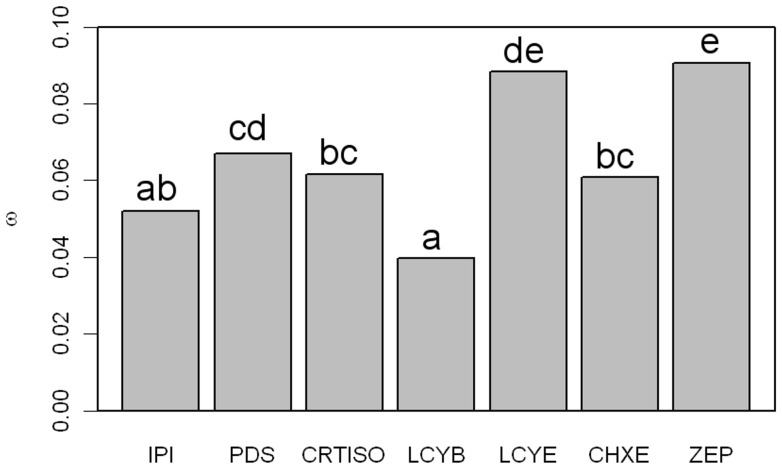
Values of dN/dS estimated by the M0 model for each carotenoid biosynthesis gene.Orthologs retrieved from seven dicots were used for this analysis. The genes are sorted according to their pathway position. The letters above each bar give the groups of significance according to the method described in [7].